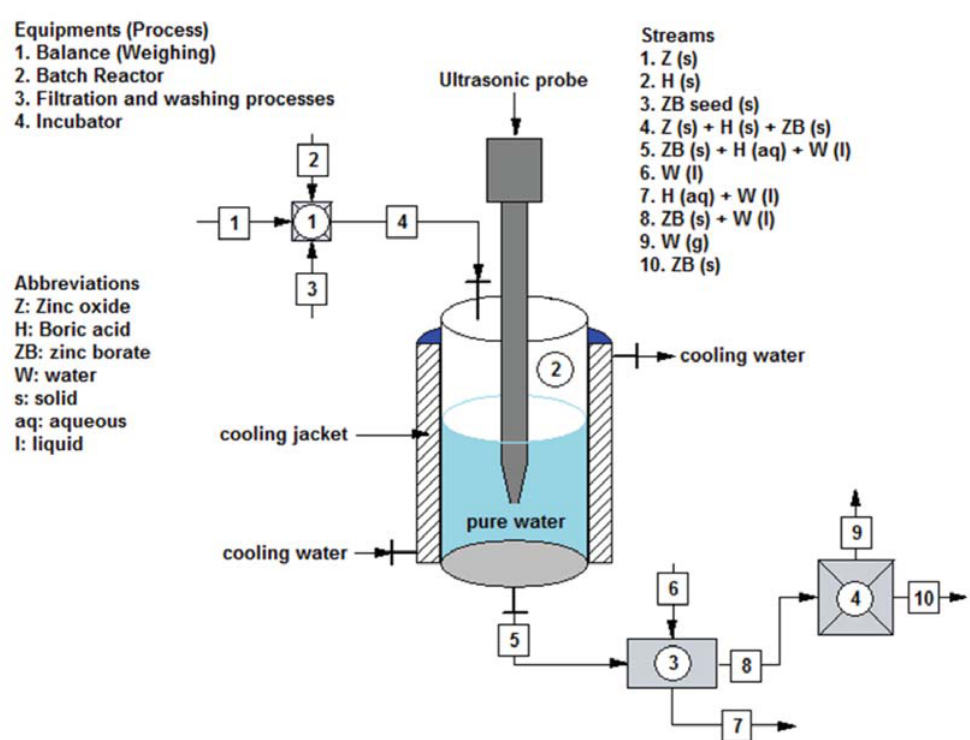
Fig. 1. Reaction scheme of the pure zinc borate